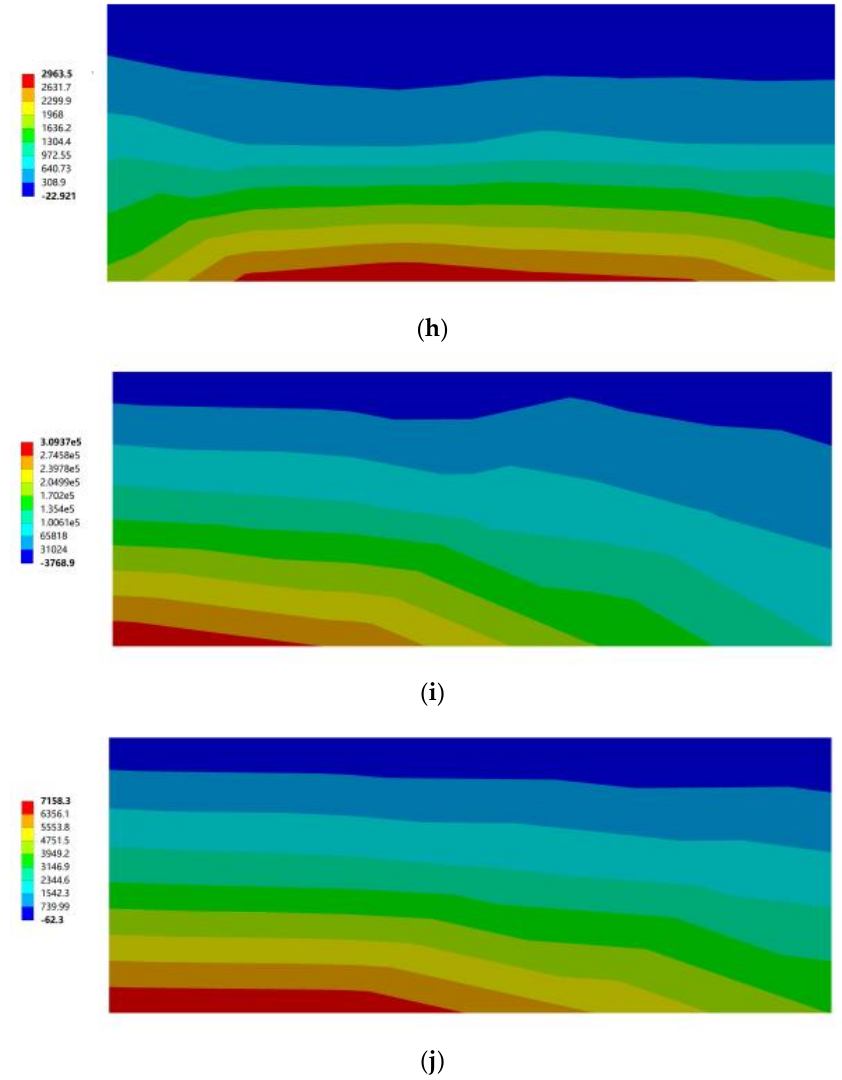
Figure 17. The maximum principal stress cloud diagram of the southward horizontal sun visor. ( a ) South to southeast wind. ( b ) South to northwest wind. ( c ) South by west 15 to southeast wind. ( d ) South by west 15 to northwest wind. ( e ) South by west 30 to southeast wind. ( f ) South by west 30 to northwest wind. ( g ) South by east 15 to southeast wind. ( h ) South by east 15 to northwest wind. ( i ) South by east 30 to southeast wind. ( j ) South by east 30 to northwest wind.